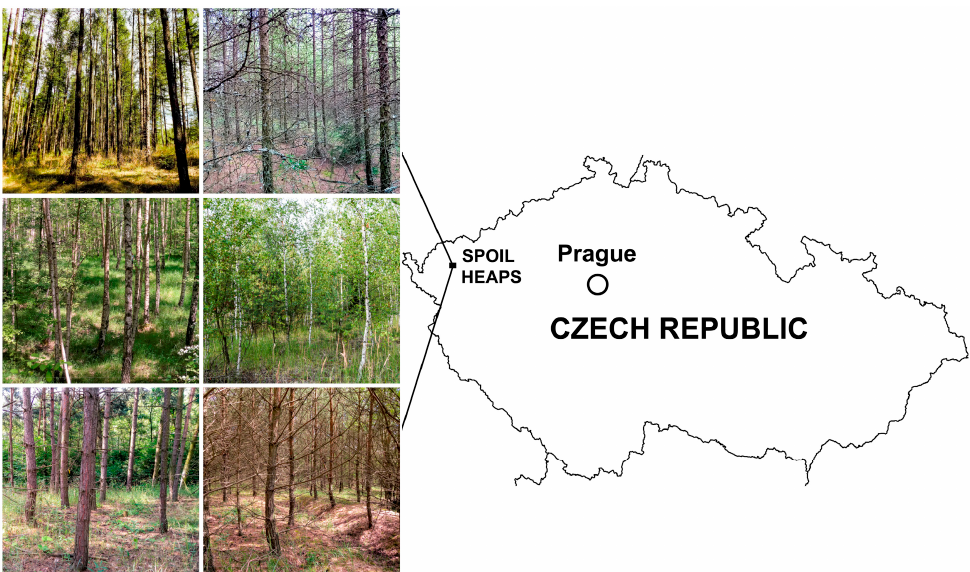
Figure 1. Location of the studied spoil